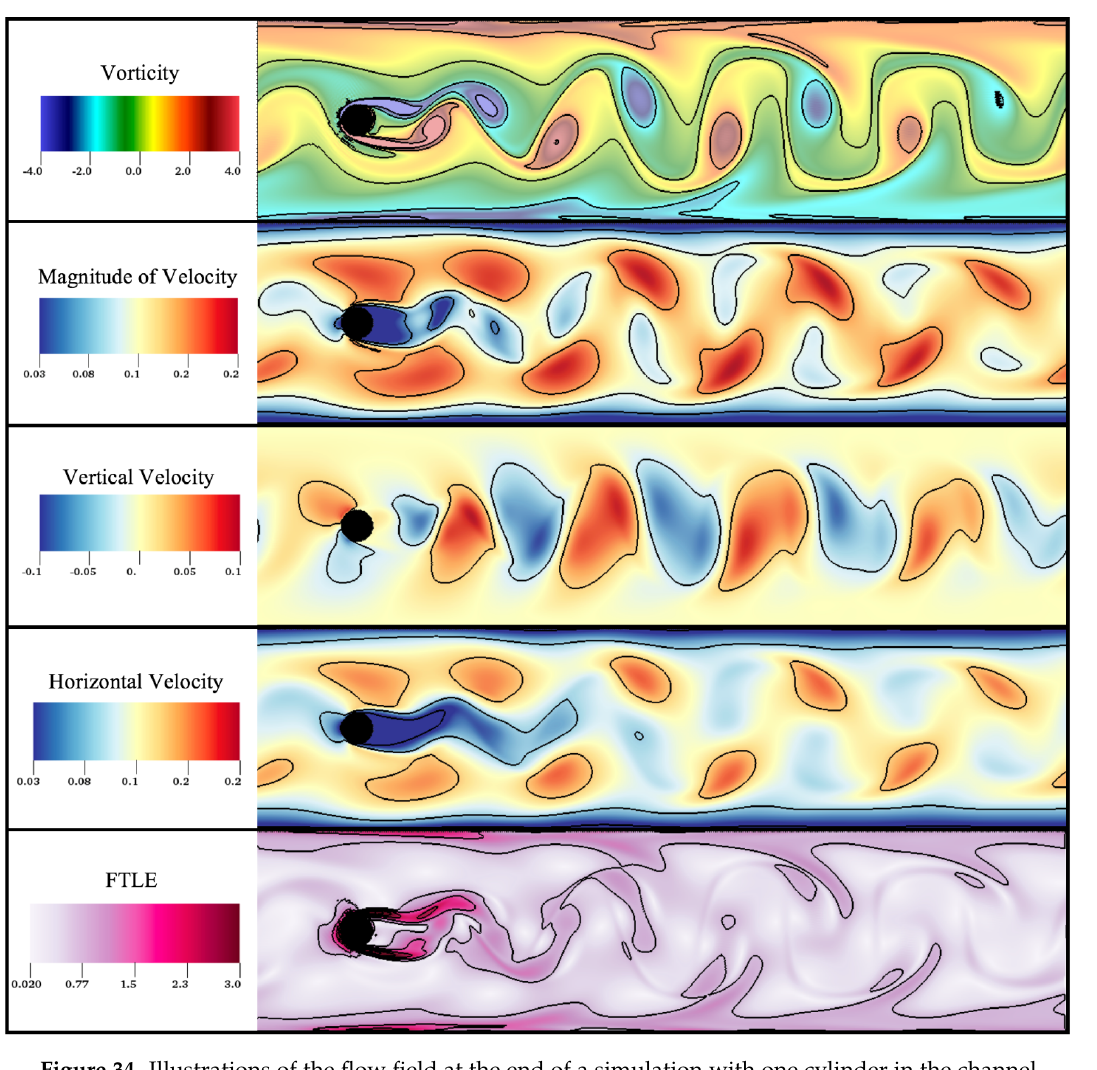
Figure 34. Illustrations of the flow field at the end of a simulation with one cylinder in the channel, showing colormaps of vorticity, magnitude of velocity, vertical and horizontal velocity, and finite-time Lyapunov